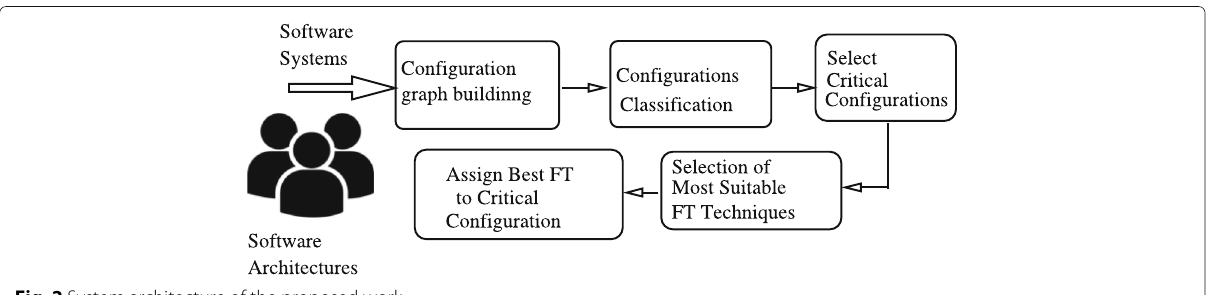
Fig. 2 System architecture of the proposed